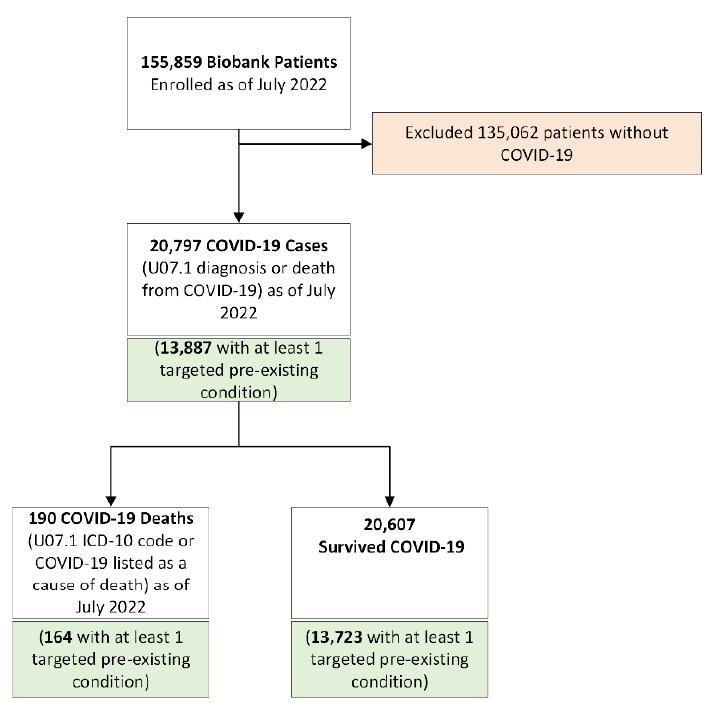
Figure 1. Cohort Selection. Cohort was determined from face-to-face visits and phecode diagnoses. De-identified data for studies of COVID-19 were provided by the Health Data Com- pass data warehouse, using unique masked IDs to connect electronic health records